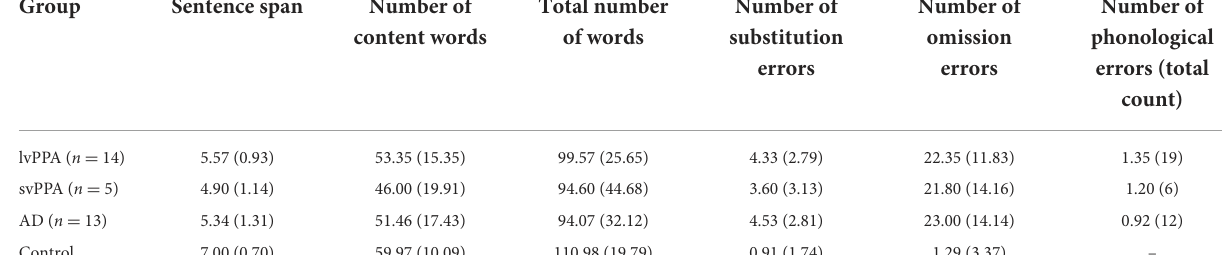
Total number Number of Number of Number of content words of words substitution omission errors errors errors (total count)